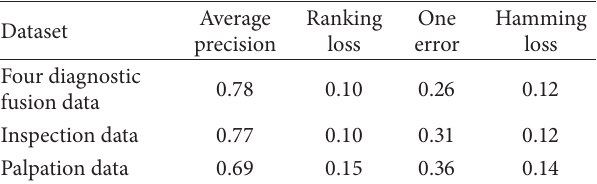
Figure 2: Frequency of syndrome factor. Table 2: Classification results without HOML.